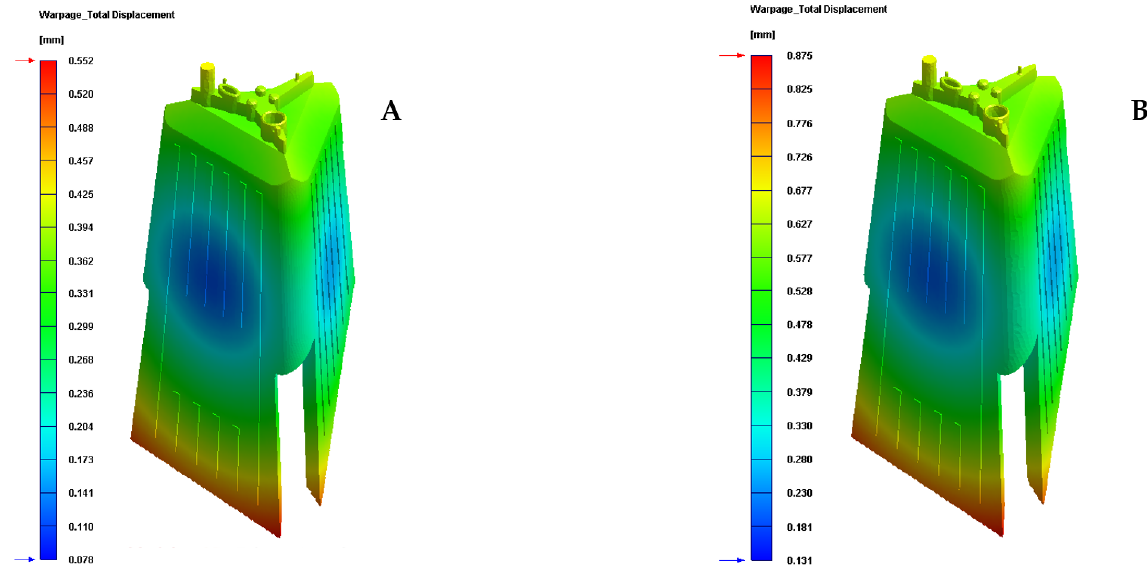
Figure 16. Warpage total displacement (mm). ( A ) New conformal cooling and Fastcool insert. ( B ) Traditional cooling. Table 10. Warpage total displacement for the analyzed cooling systems.